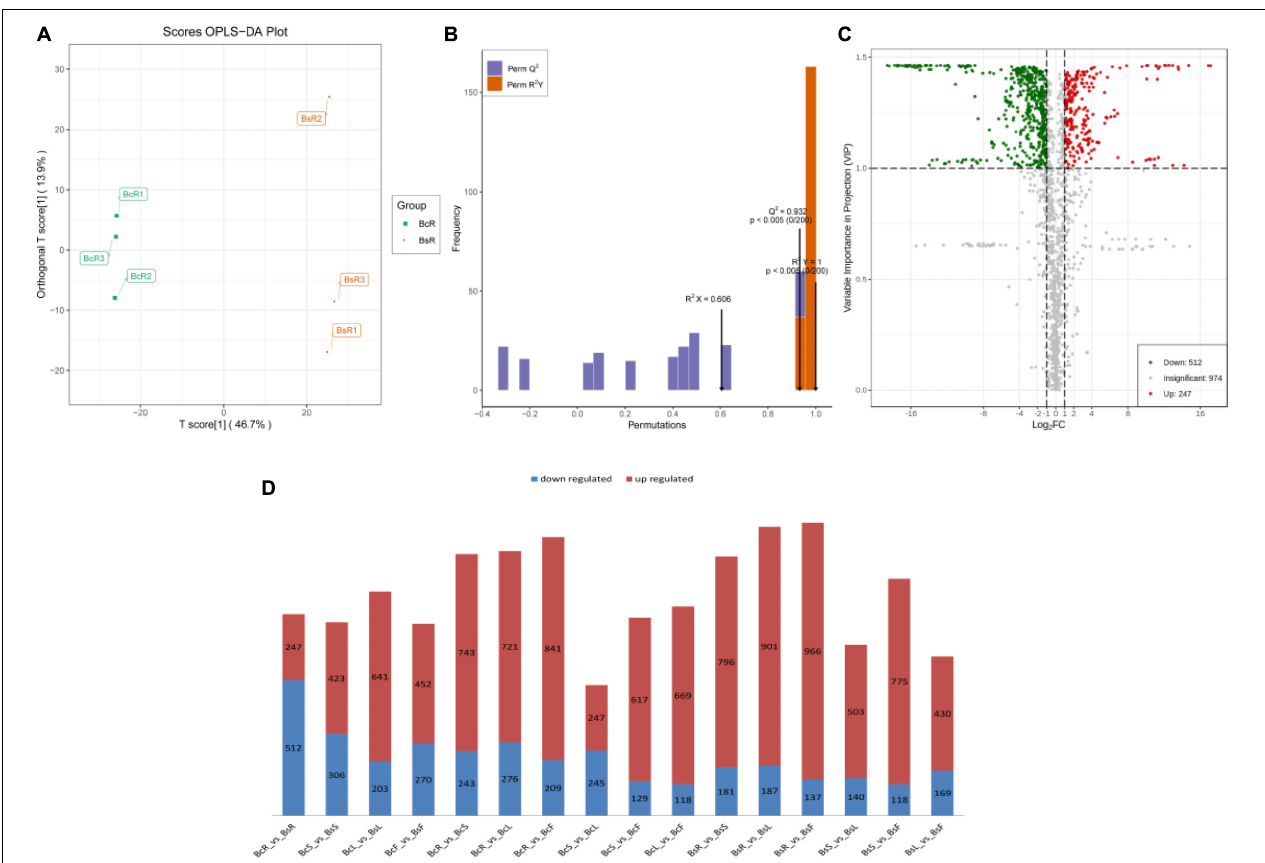
FIGURE 4 | The groups of BcR and BsR are shown, including the score OPLS-DA plot (A) , OPLS-DA model simulation verification diagram (B) , and volcano plots of differential metabolites (C) . The statistical analysis of the number of differential metabolites for all different groups is presented (D) , with the red color indicating upregulated metabolites and the blue color indicating downregulated metabolites.